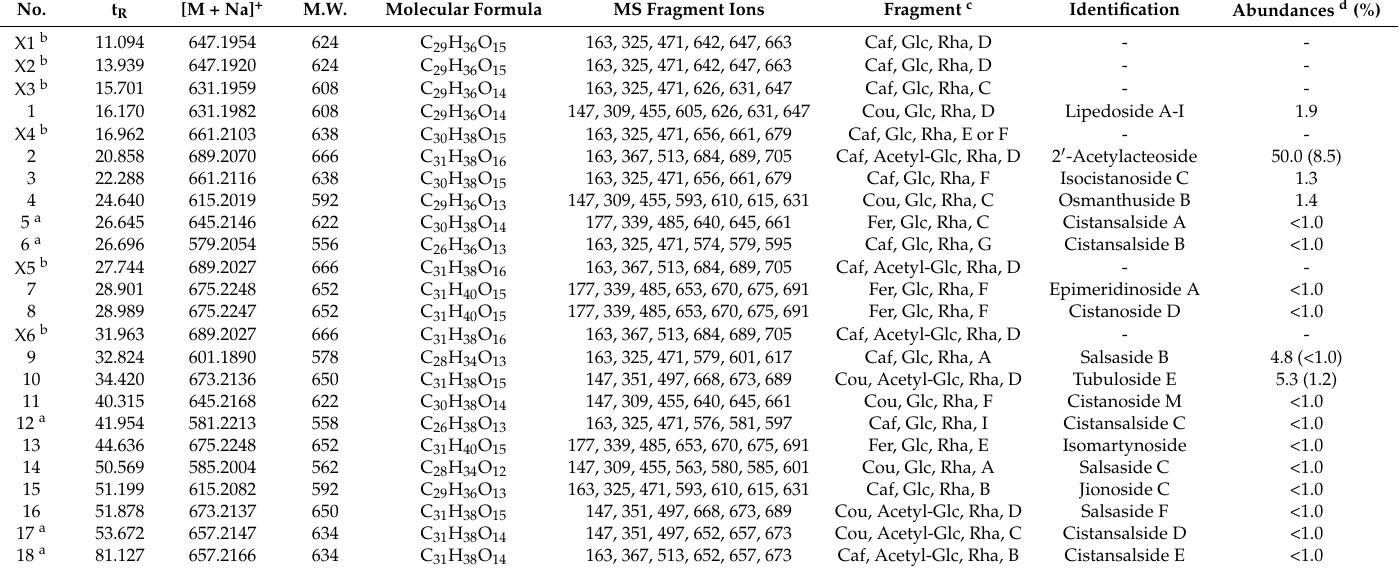
Table 1. Identification of phenylpropanoid-substituted diglycosides in EtOAc fraction of C. salsa by HPLC-ESI-QTOF-MS in positive ion mode.